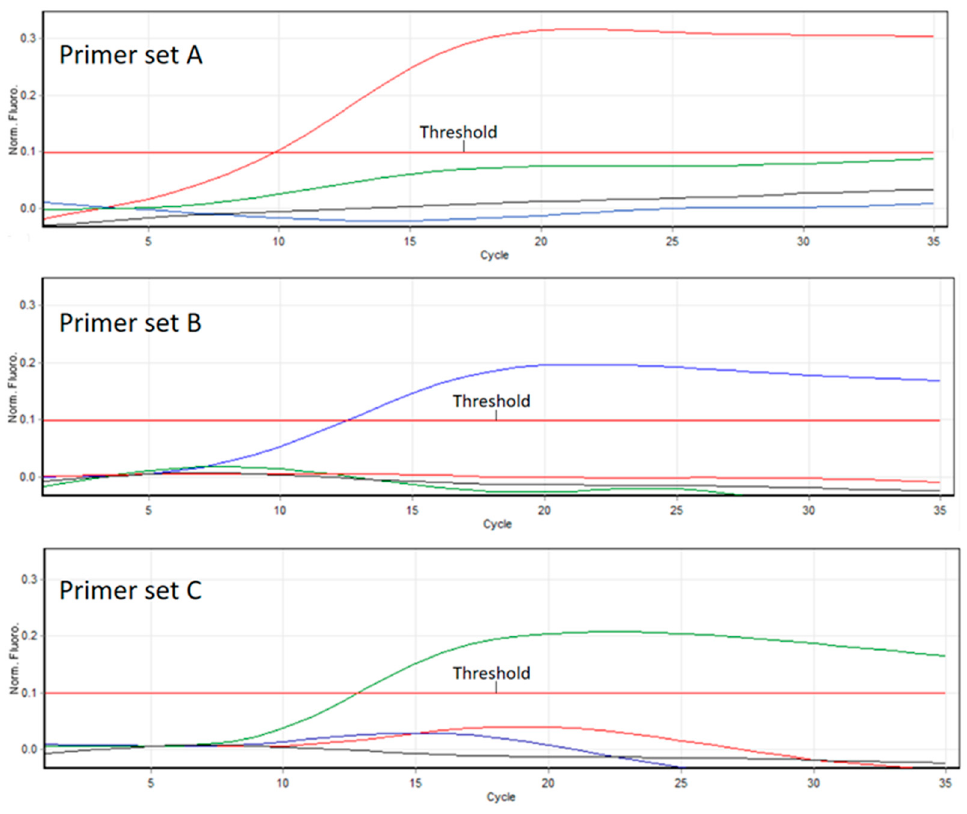
Figure 1. Amplification plot of competitive PCR. Red line = Type A, blue line = Type B, green line = Type C, and black line = no template control. All primer sets amplified the target DWV variant, and non-targets are represented by coloured lines under 0.1 fluorescence.